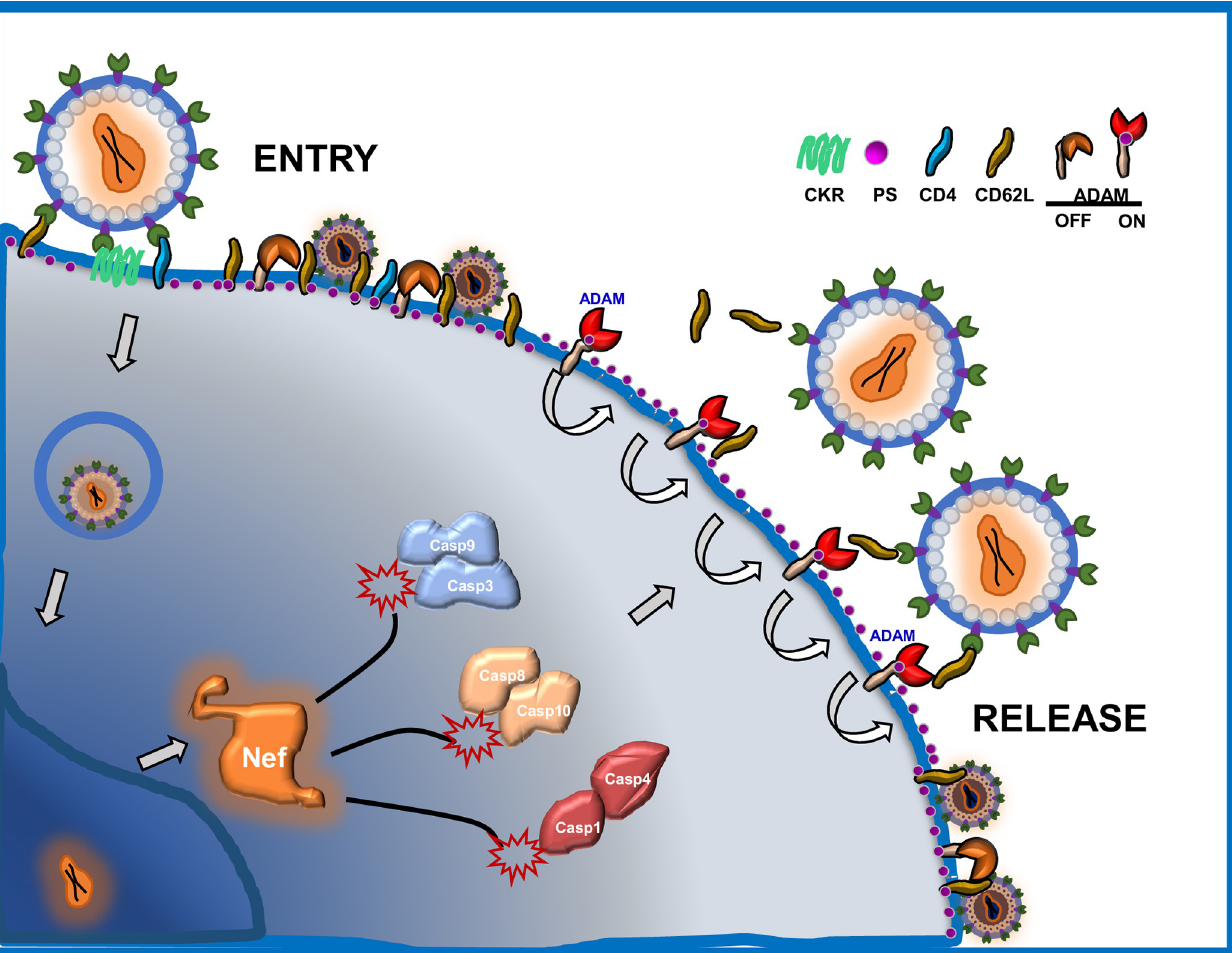
Fig 8. Targeting caspase activation suppresses the viral reservoir. Model of Nef-mediated activation of caspases for promoting PS exchange thus stabilizing sheddase activity to cleave CD62L and permit the release of viral progeny. Inhibition of this activation causes downstream tethering of budding virus by CD62L resulting in a phenotypic change of viral morphology and loss of